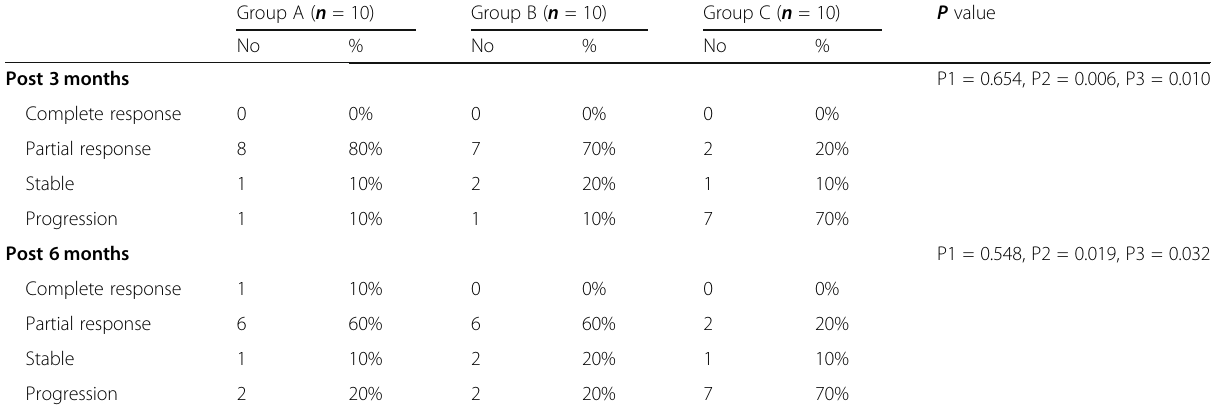
Table 2 Radiological response after 3 and 6 months of therapy measured with CT chest (modified RECIST